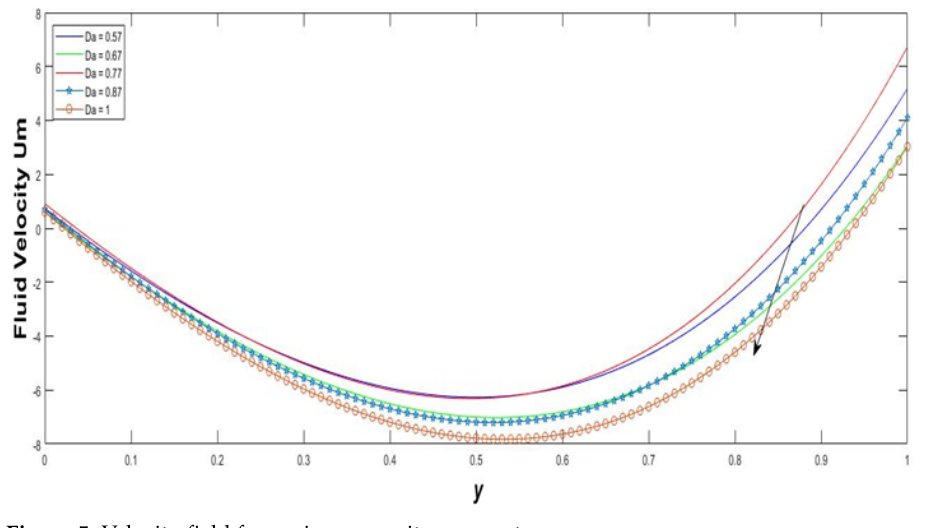
Figure 5. Velocity field for various porosity parameters.